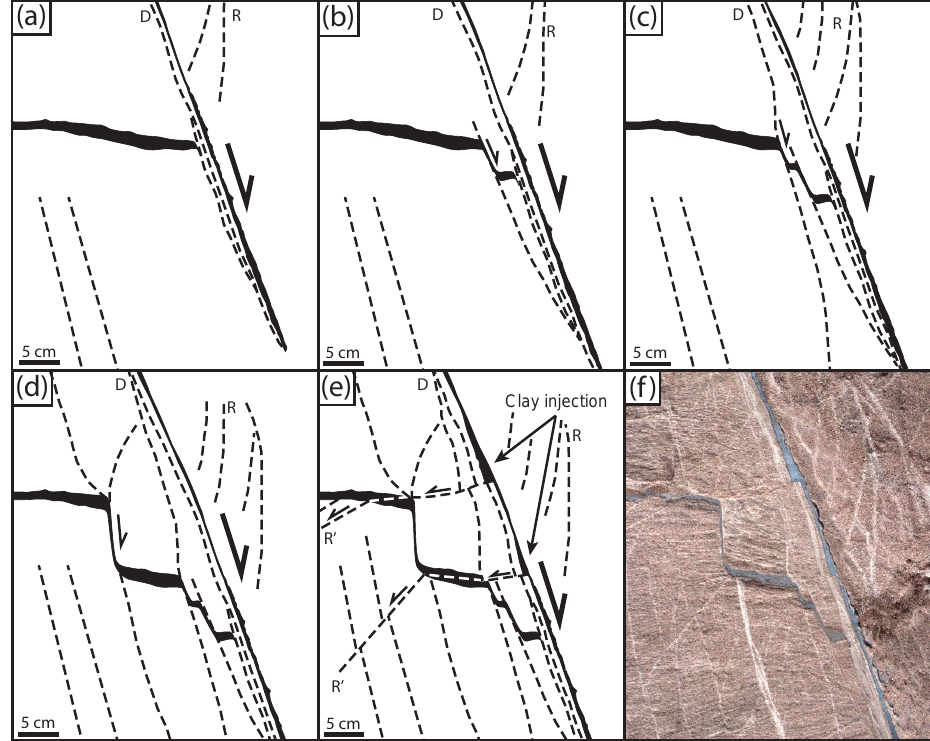
Figure 14. Sketch illustrating the evolution of a clay smear with stair-stepping due to R’ shears. R’ shears are refracted to a very shallow dip within clay layers and offset the clay layers